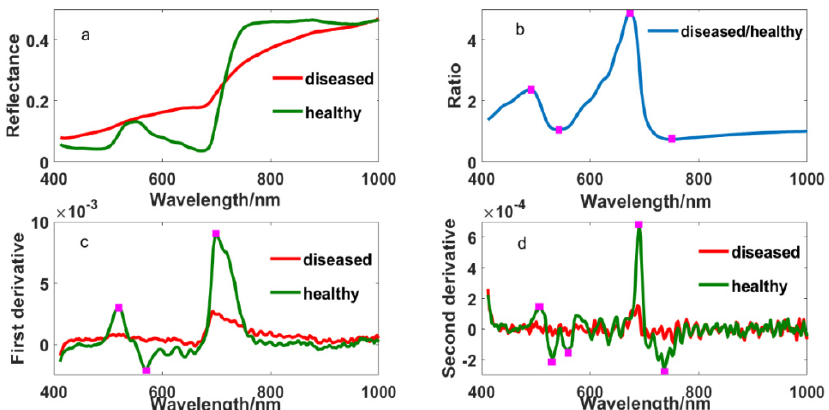
Figure 2. The spectrums of healthy and diseased leaf blade fractions: ( a ) original reflectance; ( b ) the ratio spectrum of diseased and healthy reflectance; ( c ) first derivative and ( d ) second derivative.